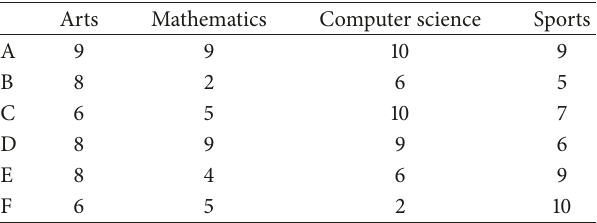
Table 1: A fuzzy formal context, where the objects are pupils and the attributes are